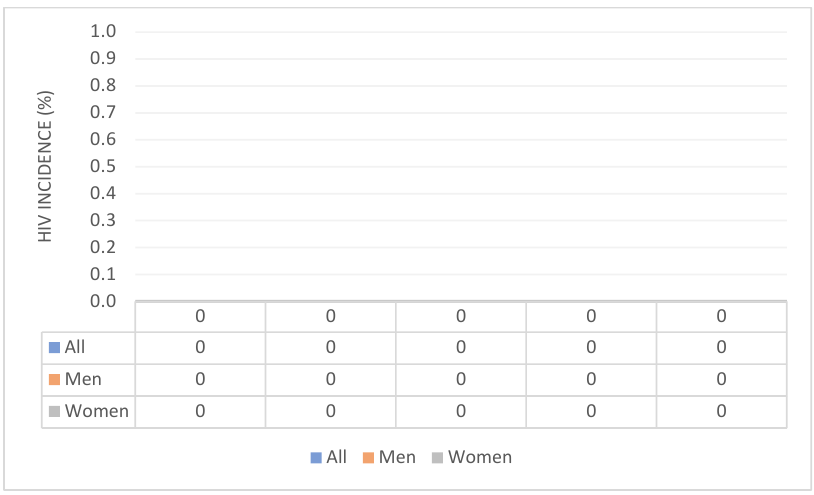
Figure 1. Incidence of HIV by age and sex, South Africa 2017. ** The sample for 12–14 was too small to stratify by sex.